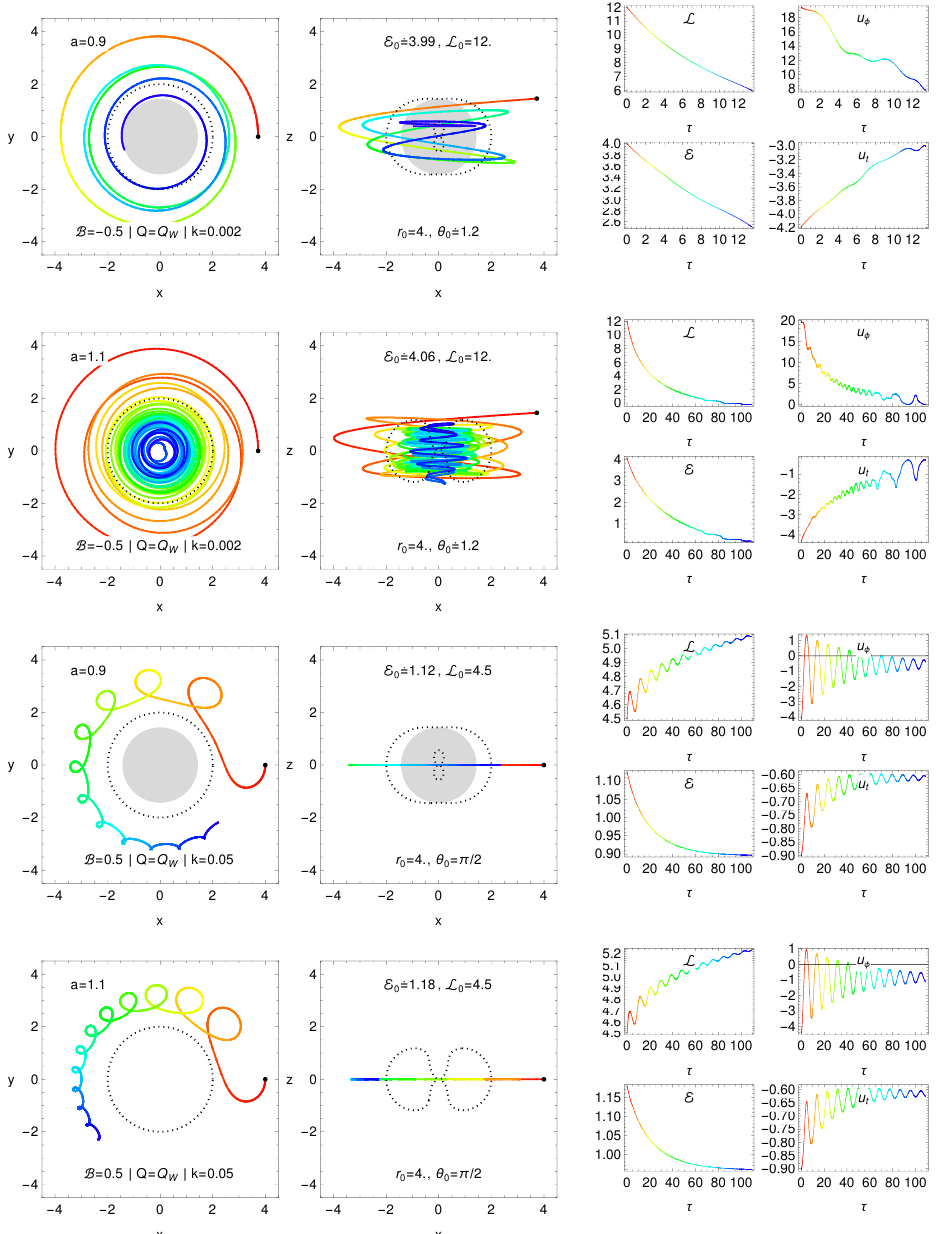
Figure 7. Charged particle radiation outside black hole ergosphere. Radiating charged particle trajectories demonstrate the role of the self-reaction force for two different kinds of orbits, comparing them for the black hole and naked singularity spacetimes. We show projections of particle trajectory into xy , xz planes, particle specific energy E , radial coordinate r , and covariant component u t , u φ , as functions of proper time τ . Change in the colors denotes the evolution with the proper time, gray disk denotes BH interior, and dotted curve shows the boundaries of the